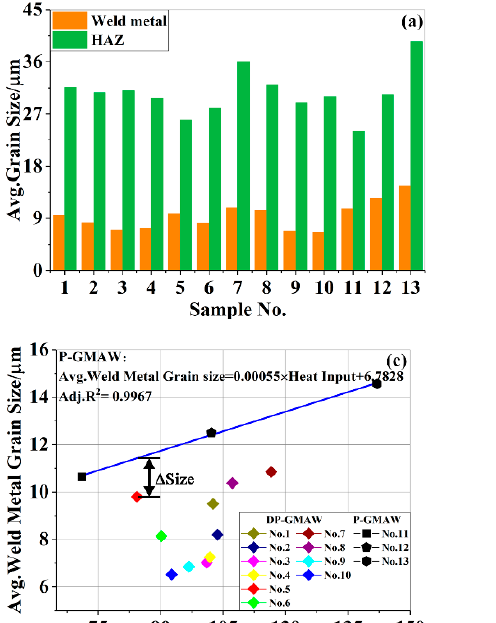
20 of 23 Figure 18. Thermal pulse helping grain refining: ( a ) process of the heat input and pool oscillation amplitude in DP-GMAW; ( b ) constitution supercooling in thermal base period; ( c ) constitution supercooling in thermal peak period. The equiaxed ferrite grains in the freshly solidified weld transforms into austenite by diffusion transformation in subsequent T b of thermal pulse. While the fast weld cooling speed reduced transition time of “ δ → γ ”, both diffusion of ferrite-forming elements and austenite-forming elements were suppressed. It is the main factor leading to increasing the size and the content of ferrite structure in DP-GMAW weld microstructure compared to P-GMAW, as shown in Figures 16c,d and 17c,d. The microstructure of HAZ of weld joints prepared by P-GMAW and DP-GMAW are shown in Figures 16e and 17e. There is no obvious difference in the grain size of HAZ between the weld joints prepared by P-GMAW and DP-GMAW respectively. Similar heat input rate between welding parameters of No.11 and No.3 may be the main reason. The average size of weld microstructure and HAZ with different welding parameters were measured using the intercept method (as per ASTM E112-10), the values are statistic presented in Figure 19a. When the base metal of HAZ is heated, the microstructure undergoes a process of recrystallization, new undistorted equiaxed grains appear in the microstructure and gradually replace distorted grains. After the recrystallization is completed, continue to heat up or prolong the elevated temperature holding time could make the grain continue to grow. The size of HAZ in weld joint mainly depends on the heat input rate, Large heat input rate leads to longer elevated temperature holding time of HAZ, which is conducive to the diffusion and recrystallization process of tissue, thus leading to serious growth of grains. The fitting curve between